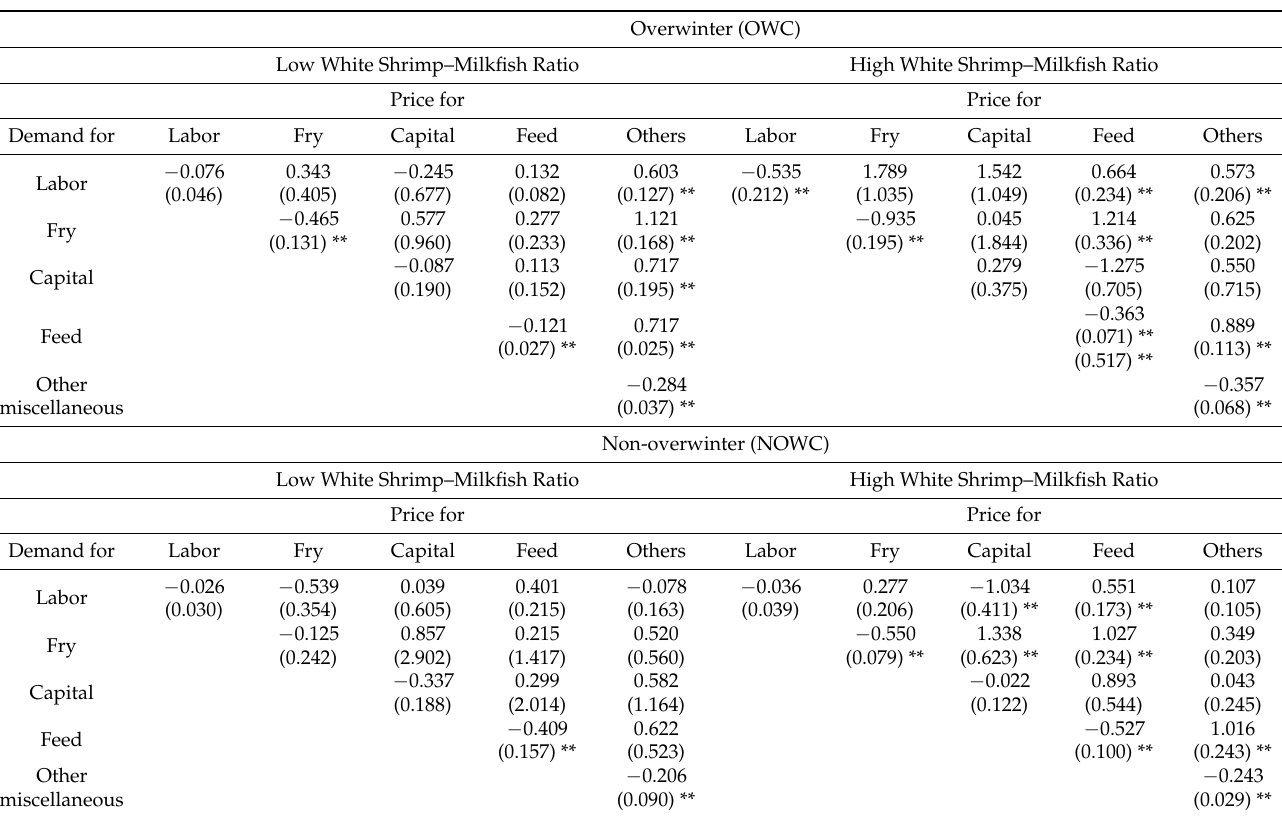
Table 3. Estimated own-price and Allen partial substitution elasticities of the observed farming household